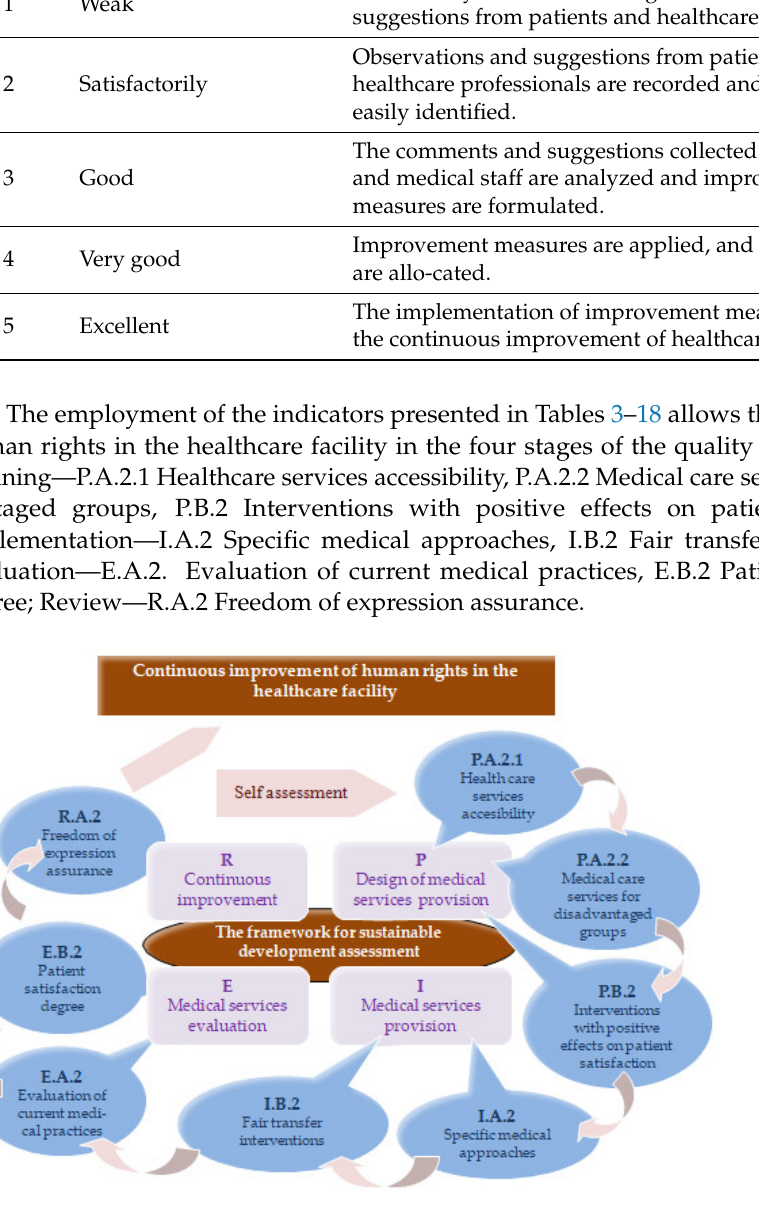
Figure 4. The cycle of continuous improvement of human rights in the healthcare facility.